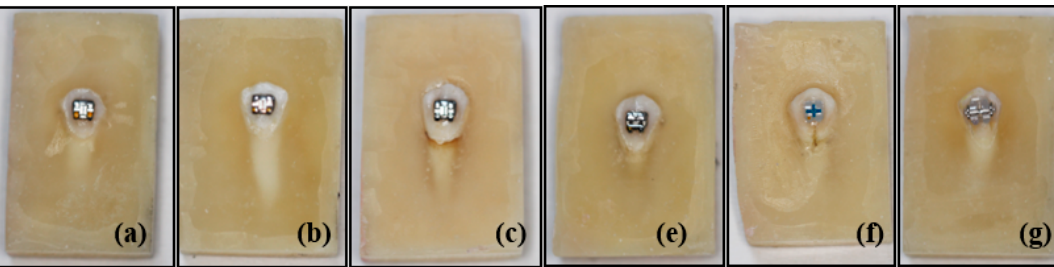
Figure 2. Photos of some samples of APC, metal, ceramic and self-ligating brackets used in the study. ( a ) APC Victory metal, ( b ) Victory metal, ( c ) Gemini metal, ( e ) Gemini SL self-ligating metal, ( f ) Clarity Advanced ceramic, ( g ) Clarity SL self-ligating ceramic bracket.